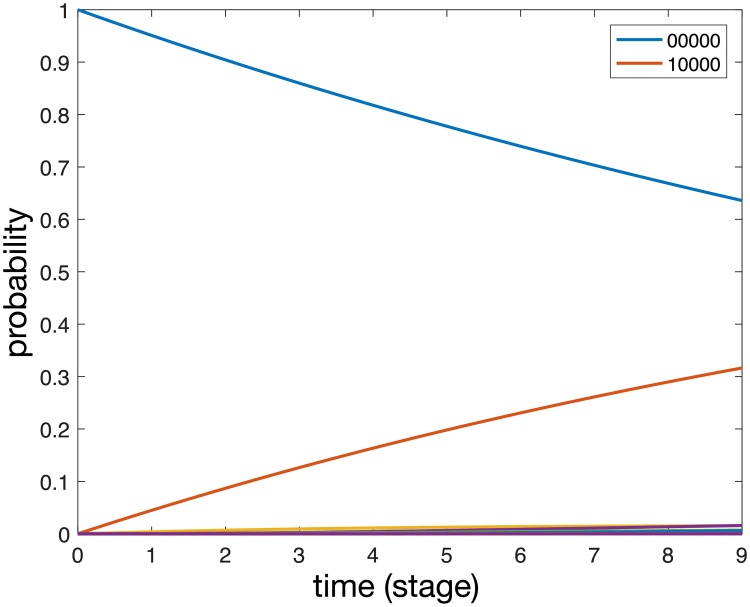
A solution to Eq (4) with parameter values obtained from the maximum likelihood method.Each curve correspond to specific state of the system.